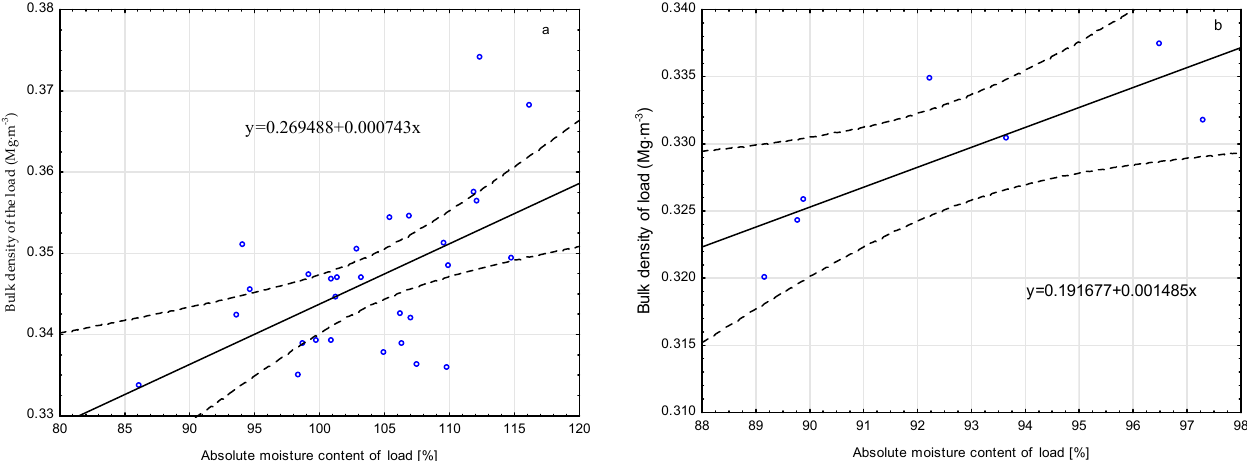
Figure 12. Graph of the dependence of bulk density (Mg · m − 3 ) on absolute moisture content for wood chips ( a ) and sawdust ( b ). Table 9. Assessment of model parameters on the dependence of bulk density (Mg · m − 3 ) chips on absolute moisture content. Parameter Parameter Value Constant term